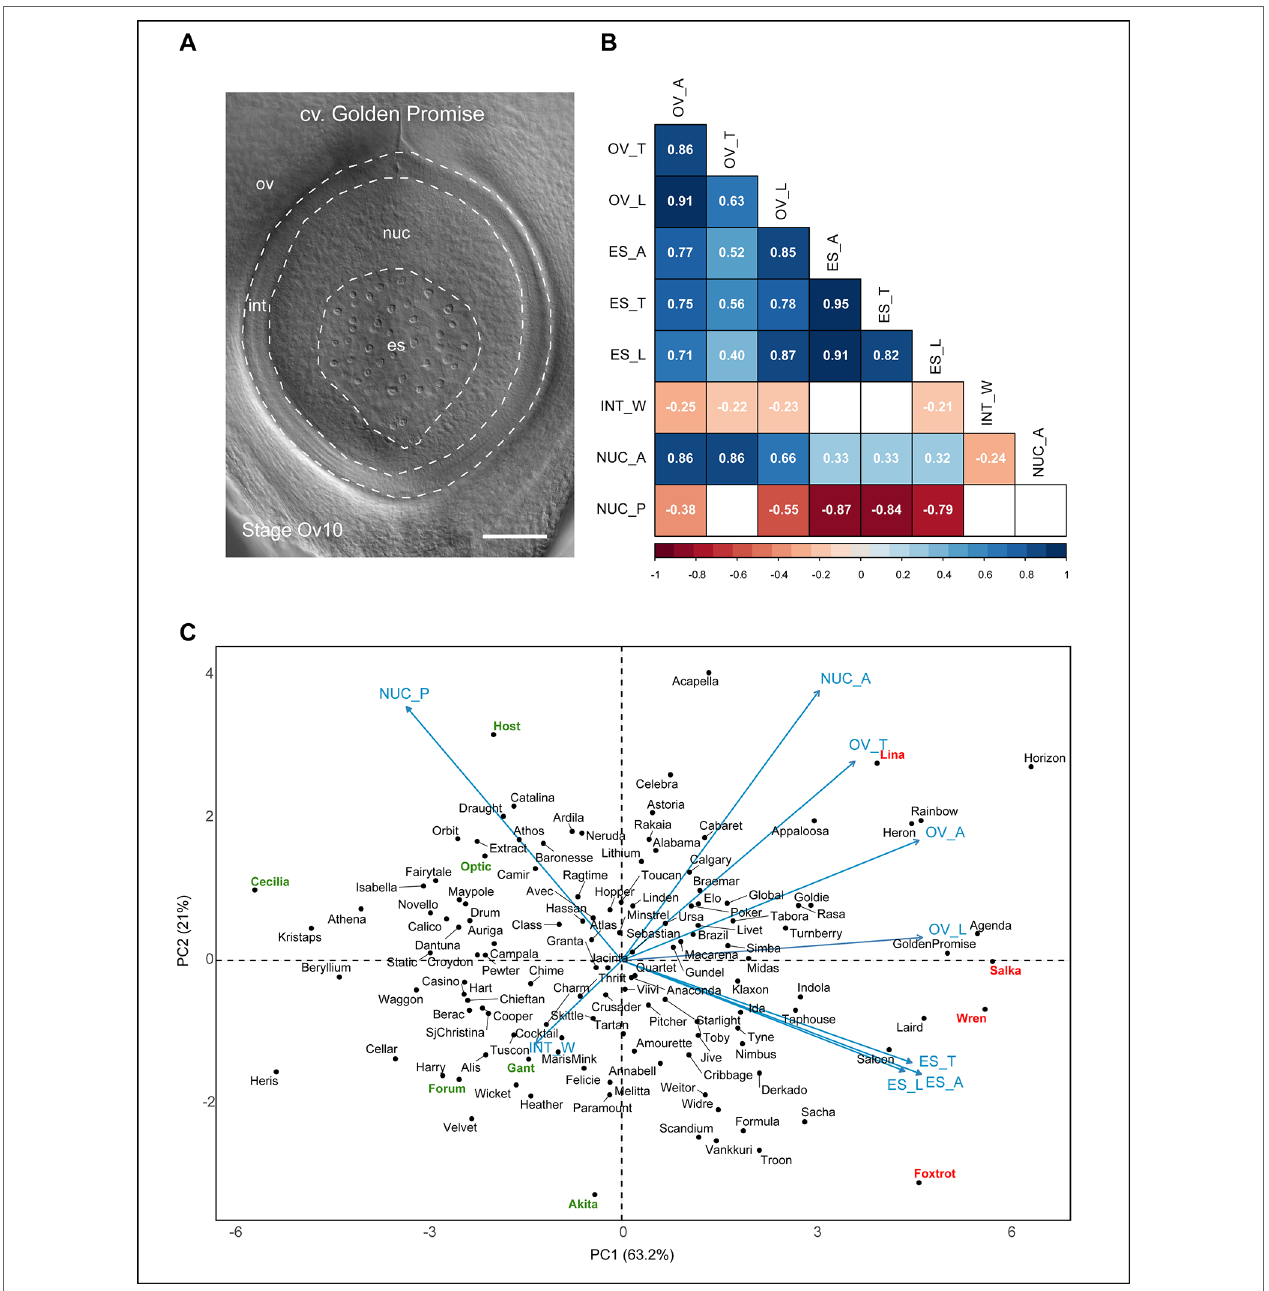
FIGURe 4 | Relationships between different barley ovule traits at anthesis. (a) Anthesis ovule from Golden Promise showing the different regions used for measurements. Scale bar = 100 µm. (B) Heat map representing correlations between nine mature ovule traits measured in 127 genotypes of European two-row spring barley. Positive correlations are shaded blue, negative correlations are shaded red. Numbers within boxes represent the correlation coefficient ( r ) value. Both box color and r value are only shown for those with a p-value of < 0.05. OV_A, ovule area (µm 2 ); OV_T, ovule transverse width (µm); OV_L, ovule longitudinal height (µm); ES_A, embryo sac area (µm 2 ); ES_T, embryo sac transverse width (µm); ES_L, embryo sac longitudinal height (µm); INT_W, integument width (µm); NUC_A, nucellus area (µm 2 ); NUC_P, nucellus proportion (%). (C) Principal component analysis of 127 genotypes of European two-row spring barley based on nine mature ovule traits. Key cultivars of interest to this study are highlighted in red (larger ovule features) or green (smaller ovule features).